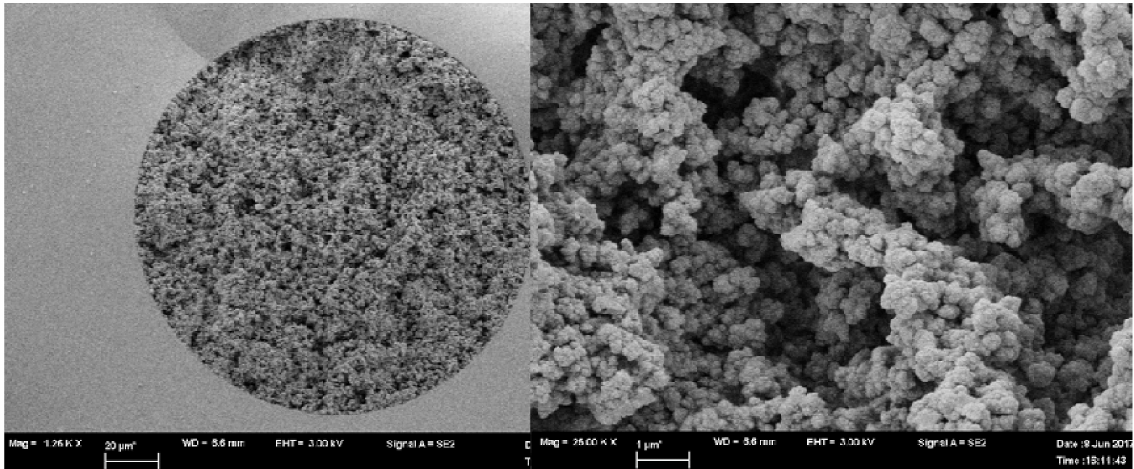
Figure 3. SEM of column D2 at 1200 × and 25,000 × (left and right, respectively) showing small microglobules with rough